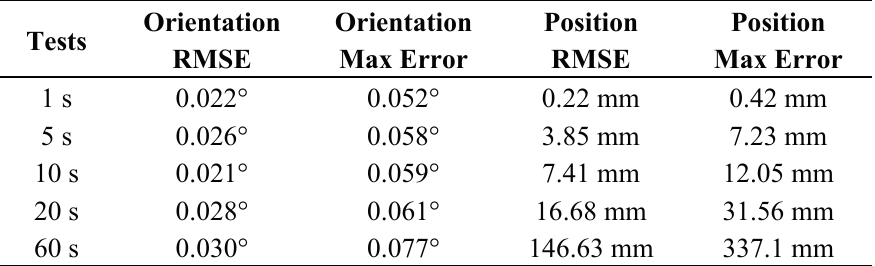
Table 3. Hybrid Tracker performance under full occlusion